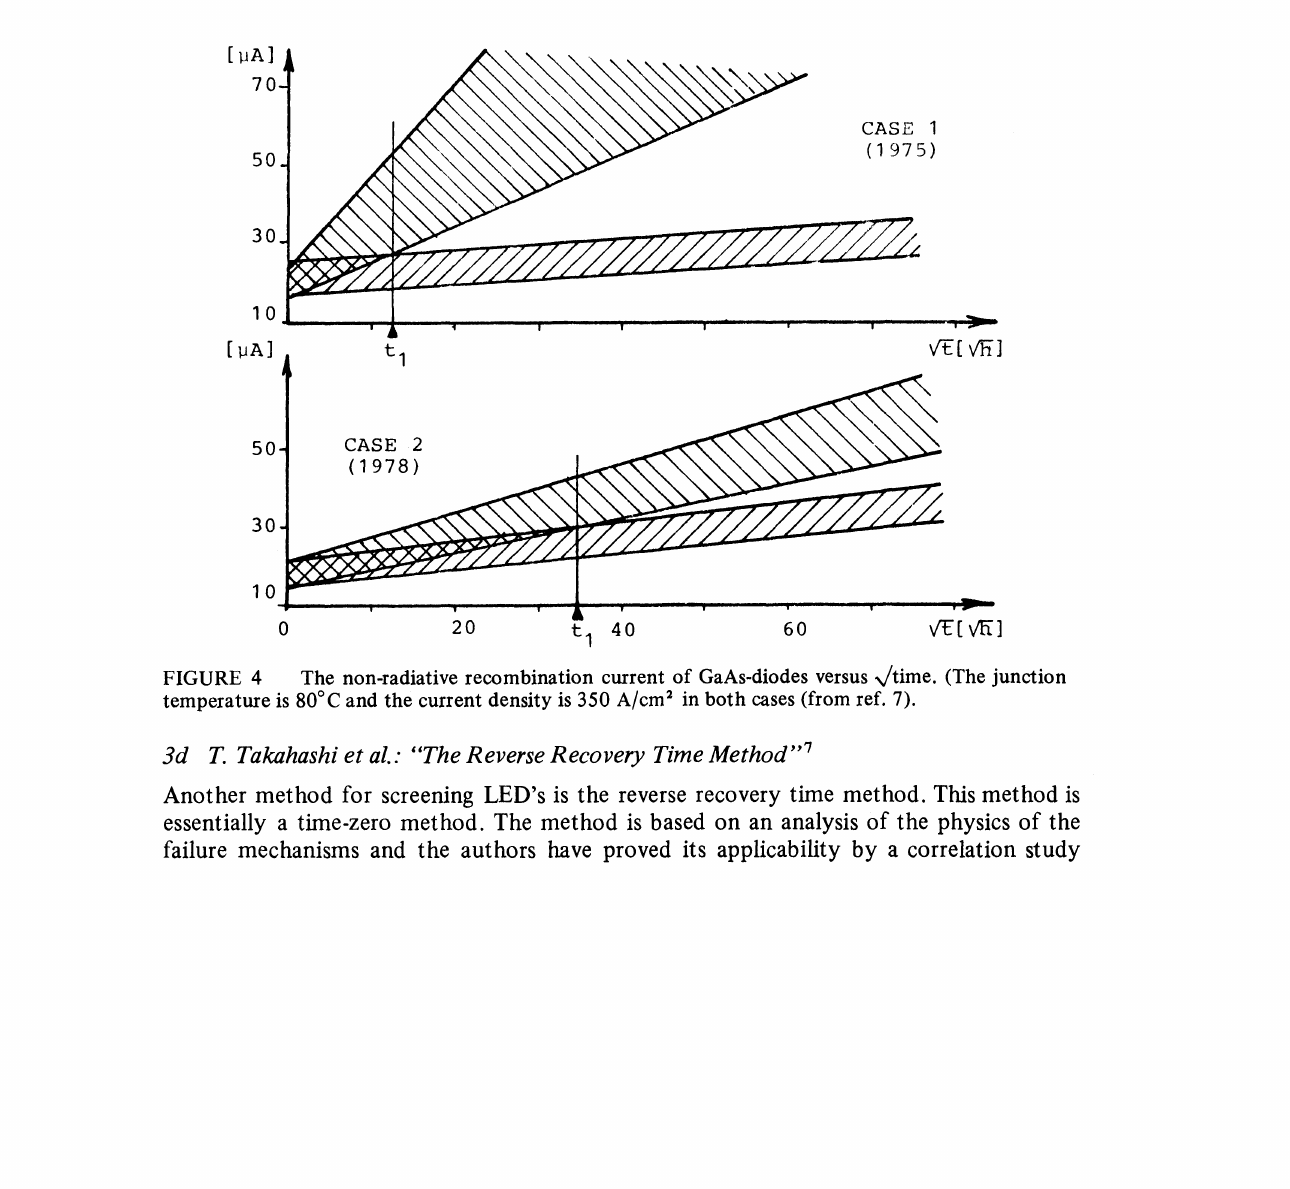
The non-radiative recombination current of GaAs-diodes versus /time. (The junction temperature is 80C and the current density is 350 A/cm in both cases (from ref. 7). 3d T. Takahashi et al.: "The Reverse Recovery Time Method